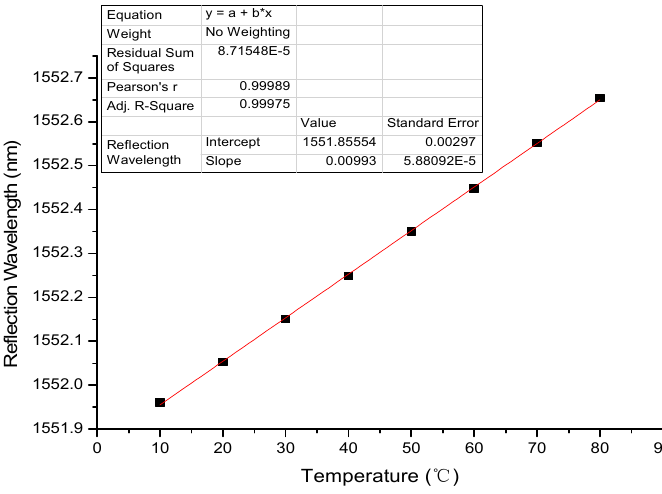
Figure 6. Calibration curve of fiber Bragg grating (FBG) temperature sensor.